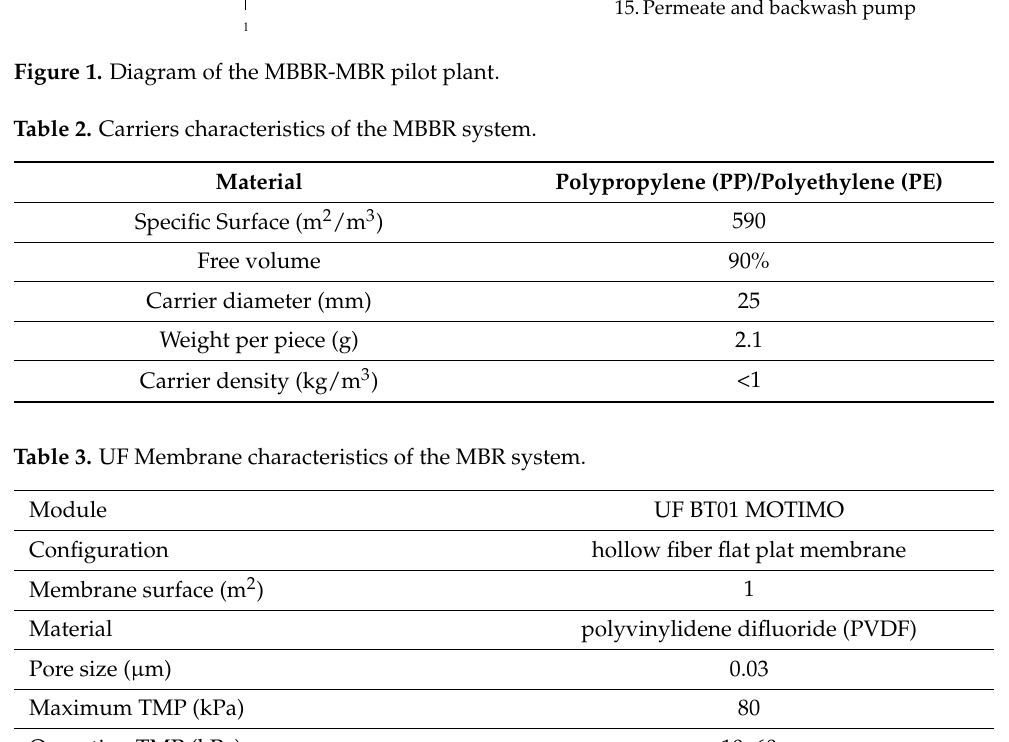
Table 3. UF Membrane characteristics of the MBR system.